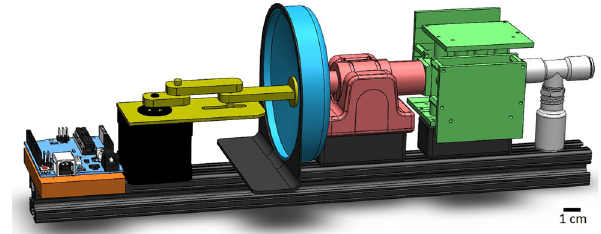
Fig. 4 GROMIT device schematic with motor controller in orange, motor in black, rotational to linear motion converter in yellow, custom 3D printed diaphragm in blue, fl ow sensor in red, metal oxide sensor array with conditioning electronics in green, and tee junction with sample bottle in white. Scale bar represents 1